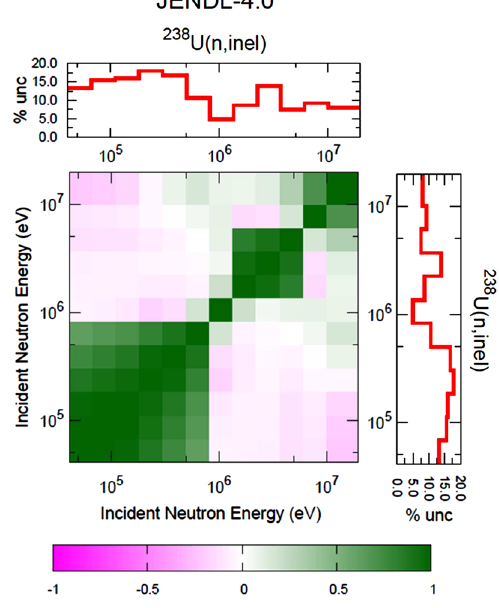
Fig. 6. 238 U inelastic uncertainty and energy correlation: – the consistency between the differences (impact on the C/E) between the two evaluated fi les and the corre- sponding uncertainties.